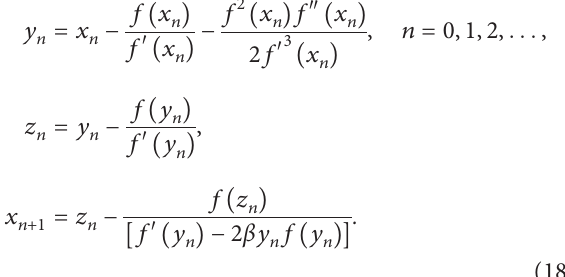
Algorithm 3. For a given x